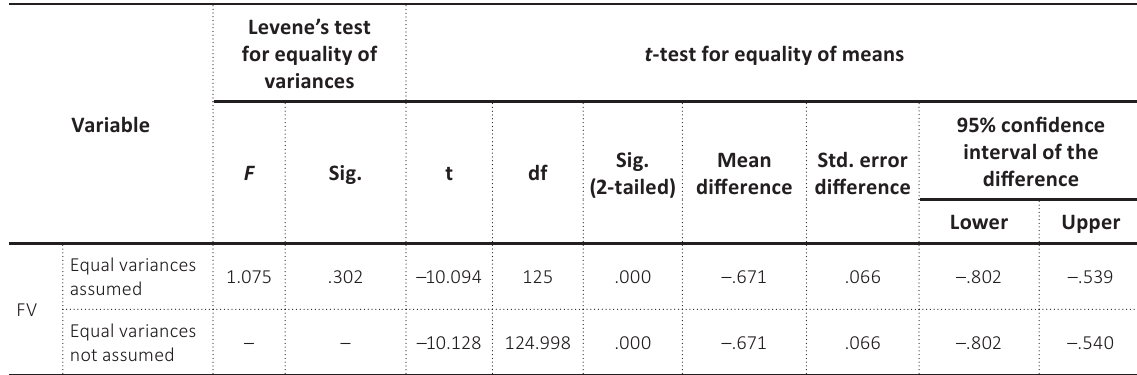
Table 2. Independent sample